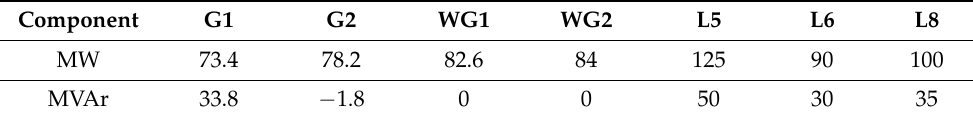
Table 1. Steady-state profile before the occurrence of an active power imbalance.